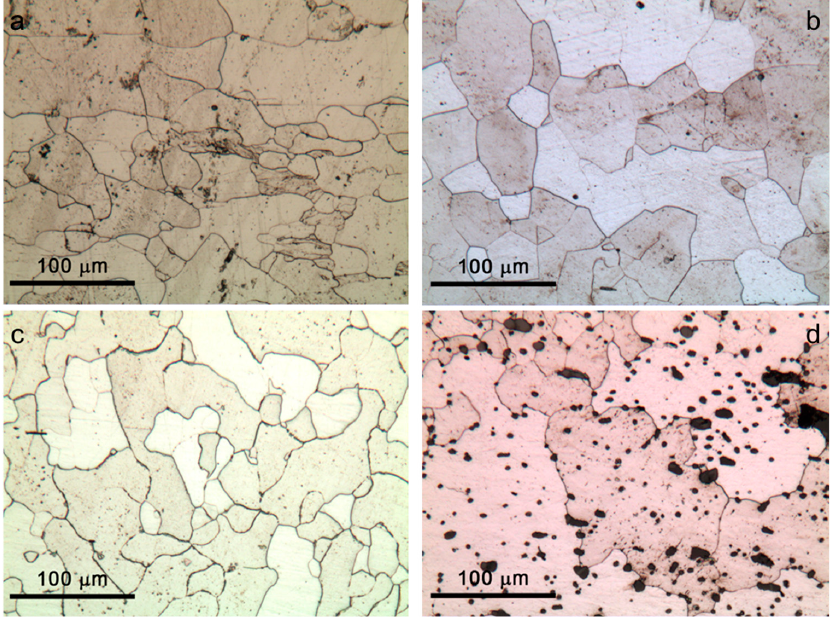
Figure 4. Microstructure observed by optical microscopy in the cross-sections of iron samples from the San Carlone and on the reference sample of puddled iron after etching with Nital2. Images of the Sample core: ( a ) Sample 44—slightly corroded sample in contact with copper; ( b ) Sample 46—slightly corroded sample not in contact with copper; ( c ) Sample 87—heavily corroded sample in contact with copper; and ( d ) Sample A—reference sample of puddled iron.